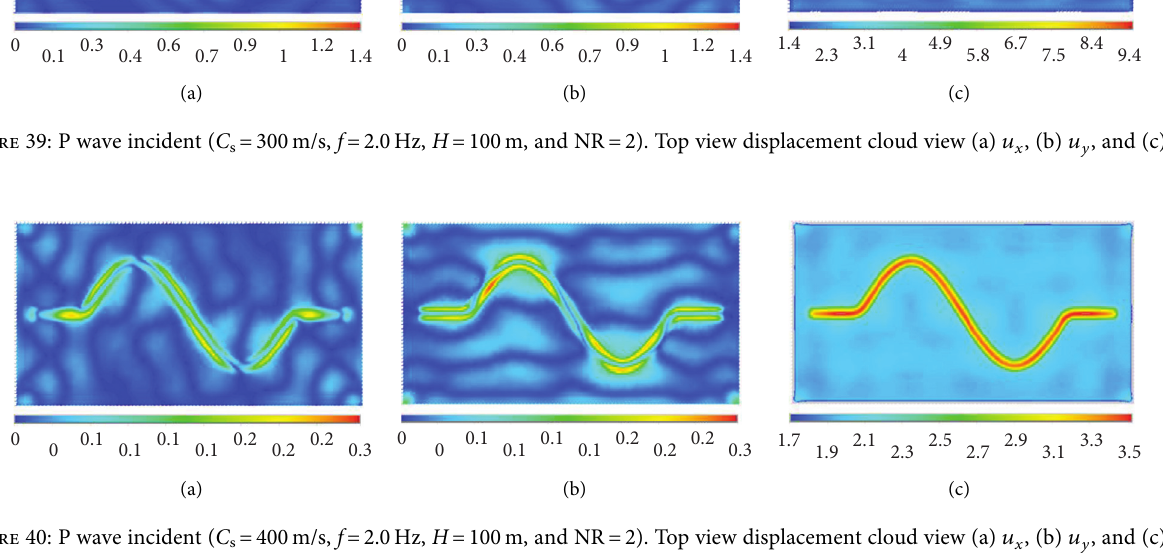
� 400m/s, f � 2.0Hz, H � 100m, and NR � 2). Top view displacement cloud view (a) u s